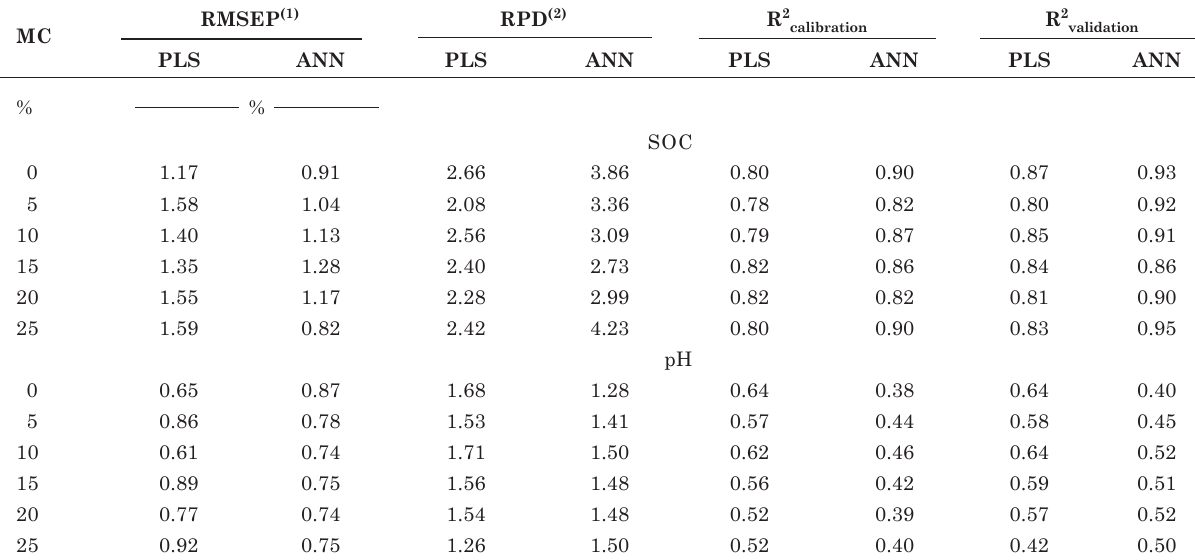
Table 2. Partial least squares (PLS) and artificial neural network (ANN) independent validation results for prediction of SOC and